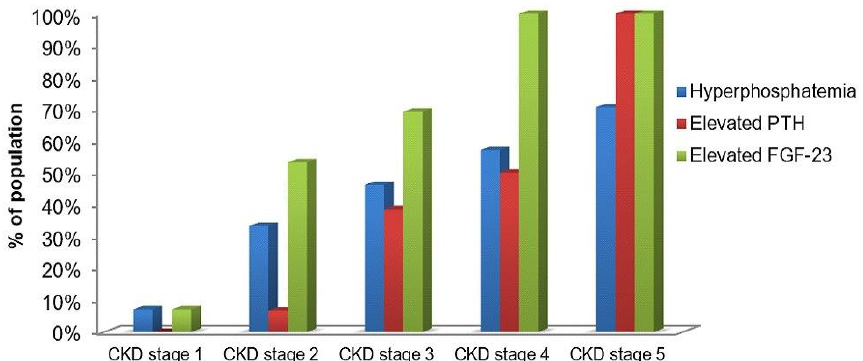
Figure 5. Proportion of study population with the elevated phosphate, PTH and FGF-23 in serum across all CKD stages (%). across all CKD stages (%).